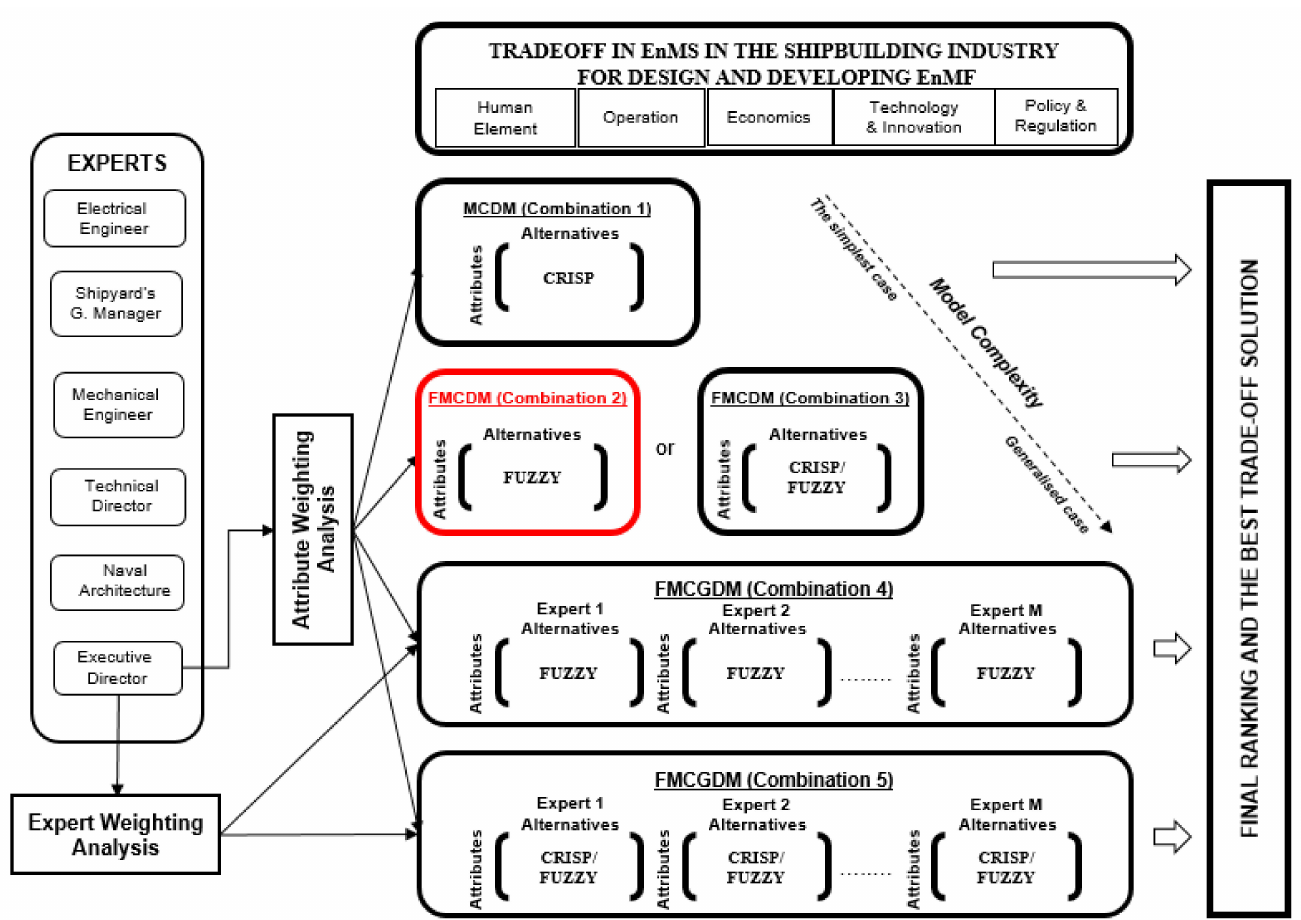
Figure 4. Generalized decision-making framework for evaluating trade-off solutions. Source: Adapted from